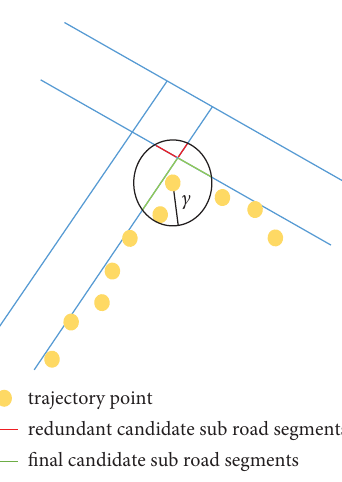
Figure 3: Redundant candidate subroad